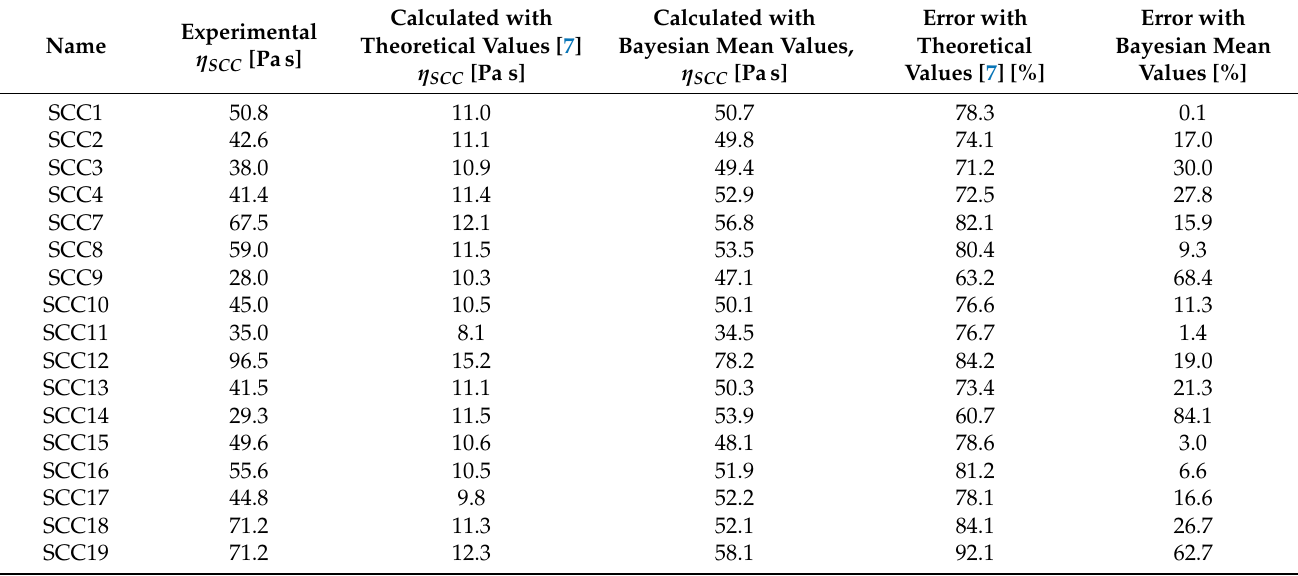
Table 8. Comparison between experimental values and models, and error estimated for self-compacting concrete (Feys et al. [39]).